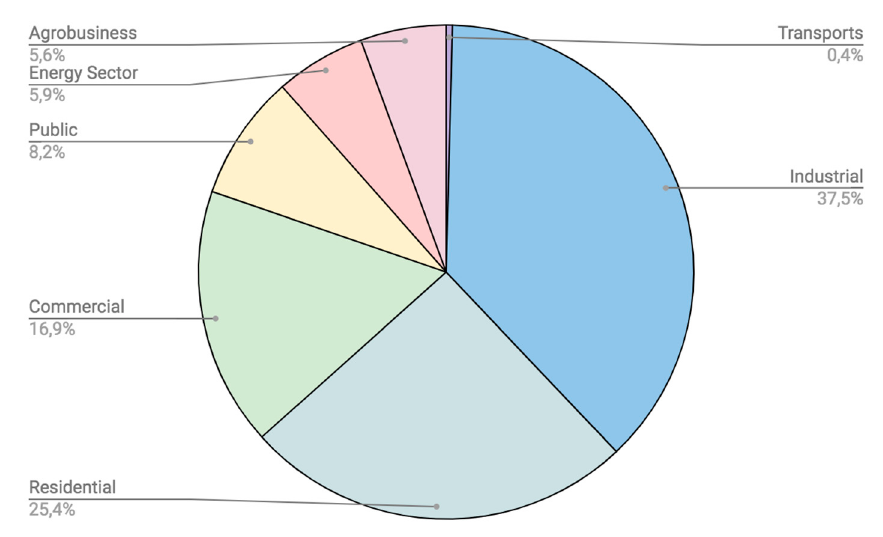
Figure 1. Brazilian matrix of electricity consumption by sector—BEN 2019 [4].